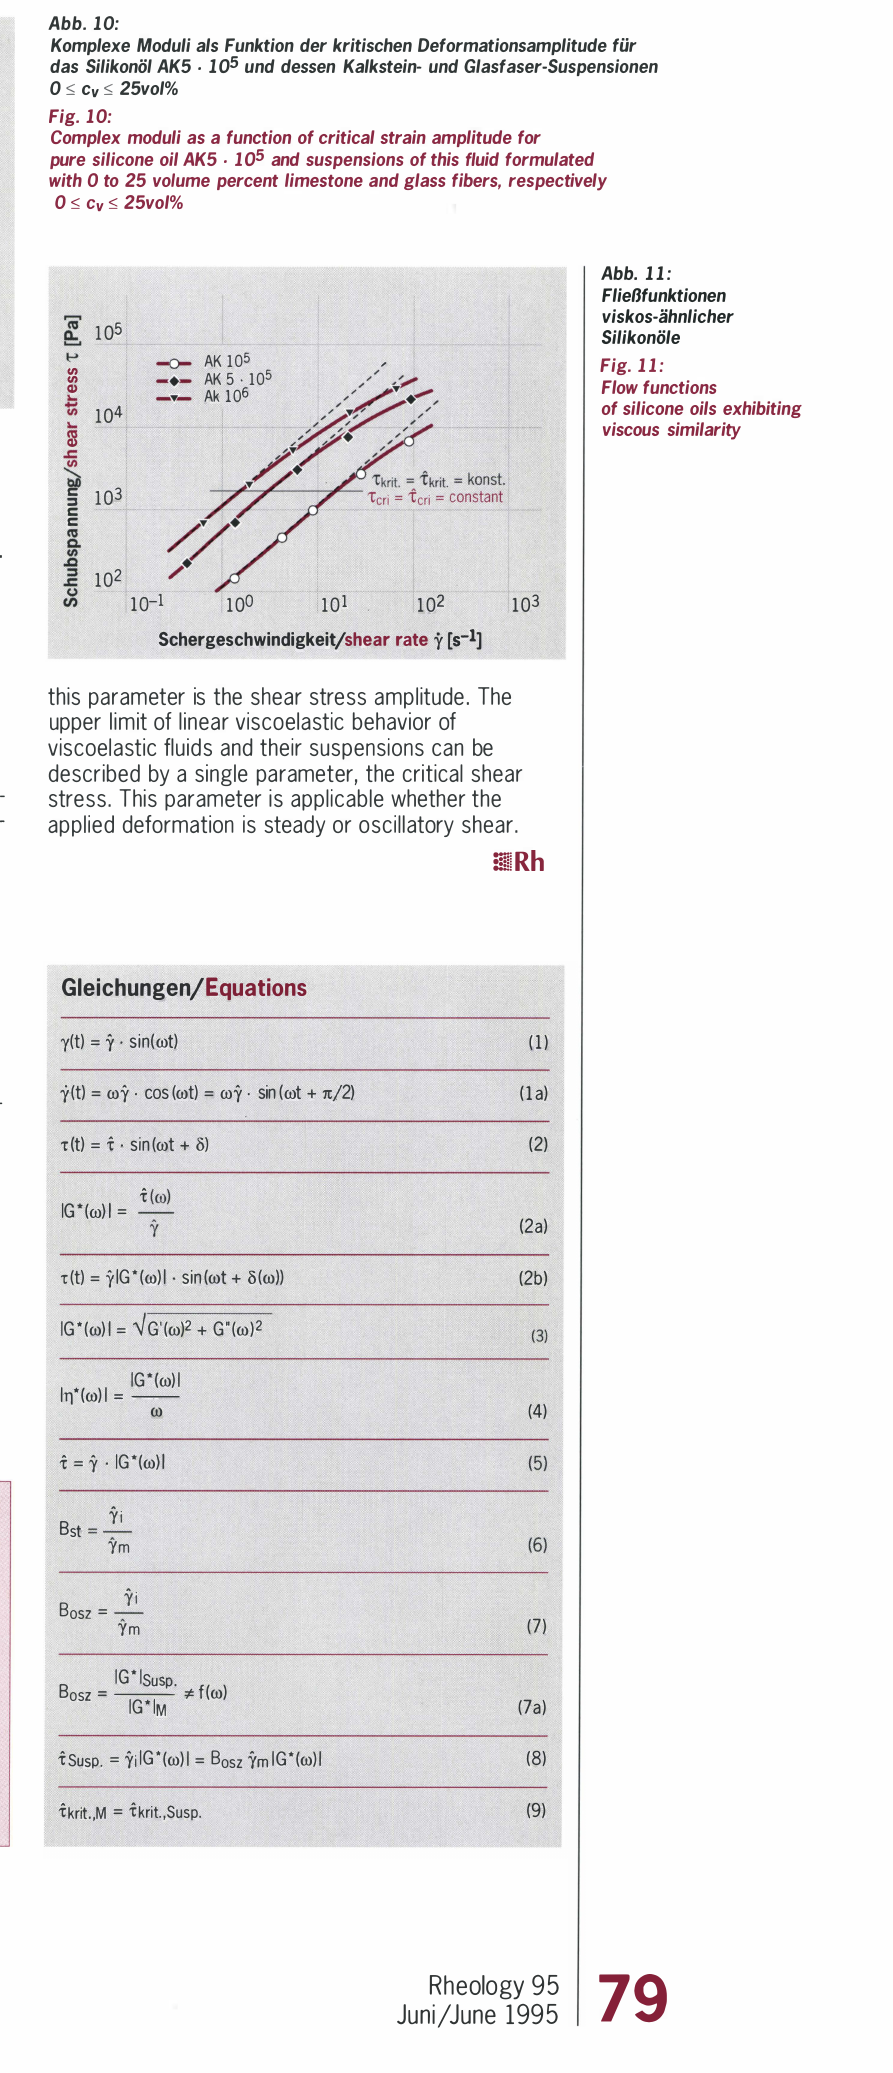
Fig. 10: Complex moduli as a function of critical strain amplitude for